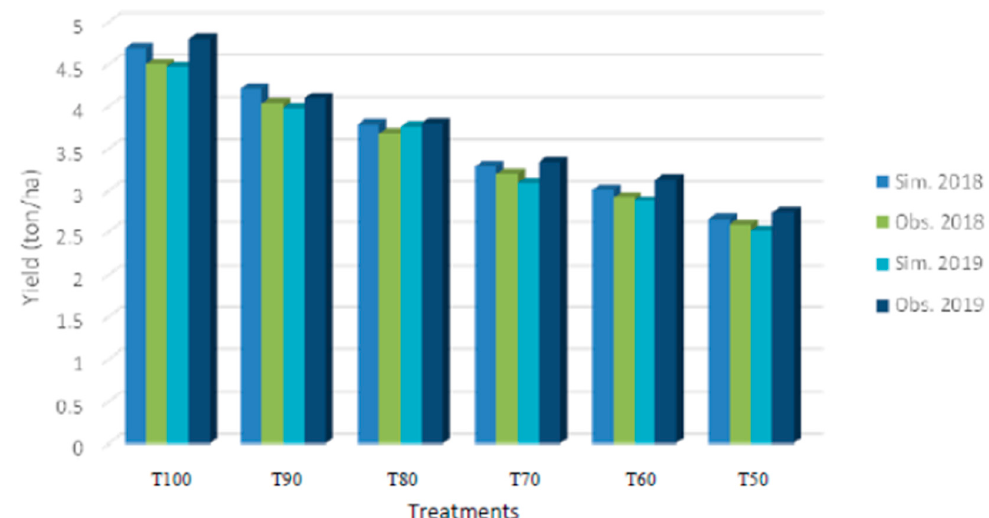
Figure 10. Comparison of the yield (t/ha) simulated by the AquaCrop model with values observed for the winter wheat crop at different water stress levels.